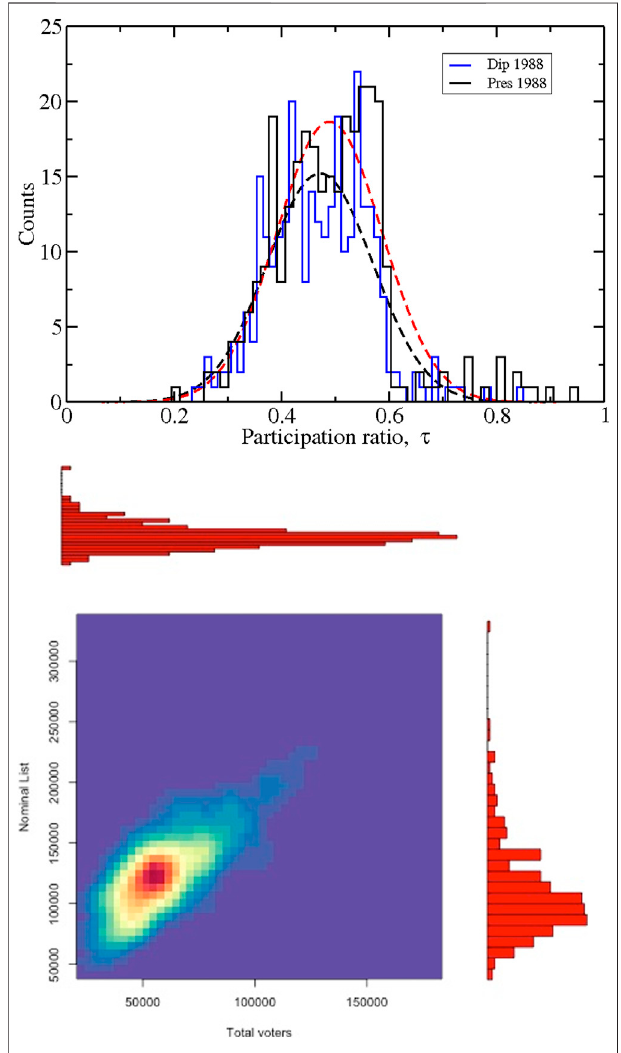
FIGURE 1 | In the upper panel, we present the participation ratio, τ , for the deputies (blue histogram) and presidential case (black histogram) for the 1988 election forthe 300districts.The normal fi tting appears for each case as the broken line. In the lower panel, as a heat map, the distribution of Nominal List and the total number of voters of the presidential election are presented.Thecorrespondinghistogramsappearattherightandtop.Weuse the of fi cial results published in Dictamen del Colegio Electoral (1994) for the number of votes and the data for deputies published in Centro de Estudios de la Democracia y Elecciones (1991) for the Nominal List. The later number was one of the reasons (among many others) that the 1988 election was considered rigged. So, the results for president are an approximation and for the presidential case is an exercise. Refer to text for